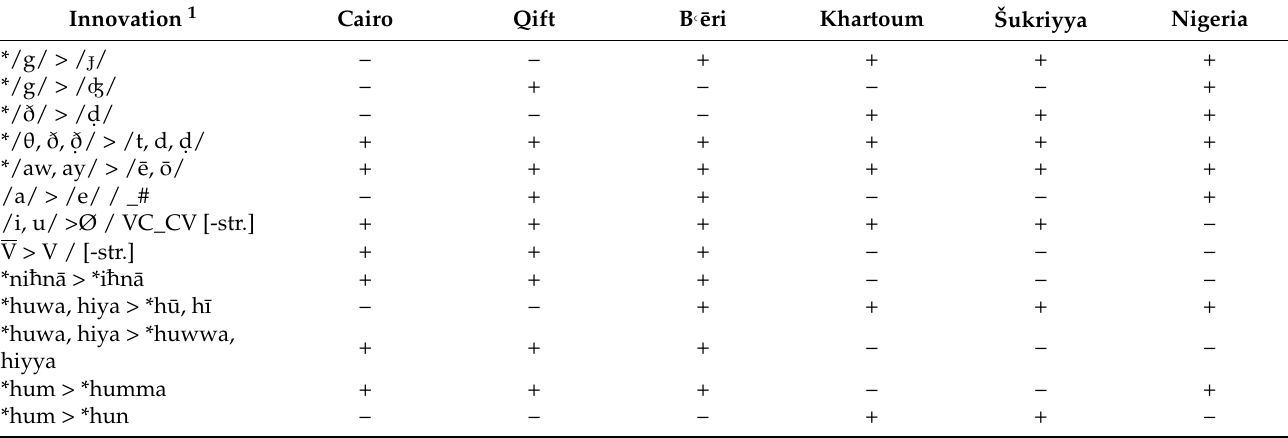
Table A1. Values for Historical Glottometry Analysis of Arabic Dialects of the Egypto-Sudanic Region. Innovation